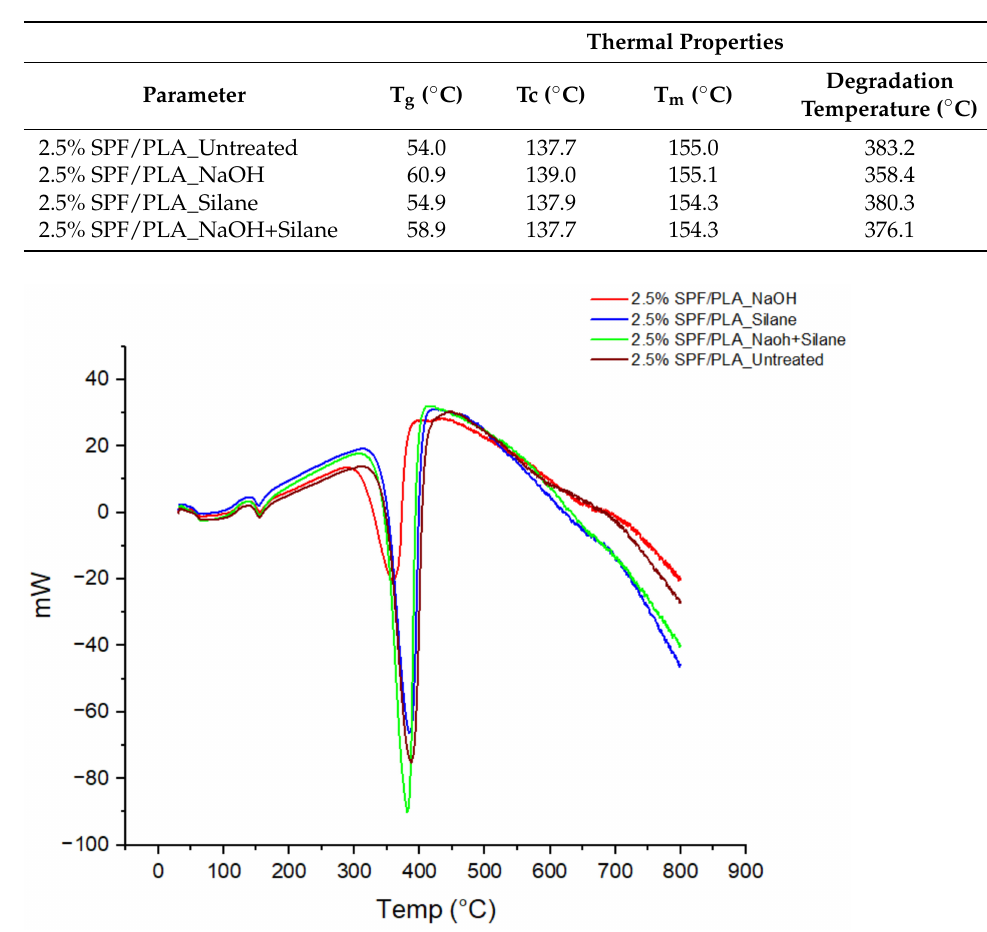
Figure 6. DSC results of 2.5% SPF/PLA filament